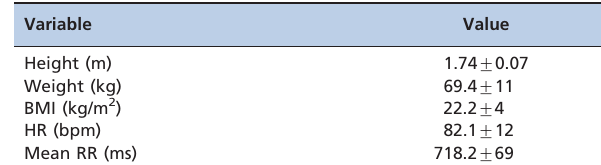
Table 1 - Baseline heart rate, mean RR interval, weight, height and body mass index of the volunteers. Meters; kilograms; beats per minute;